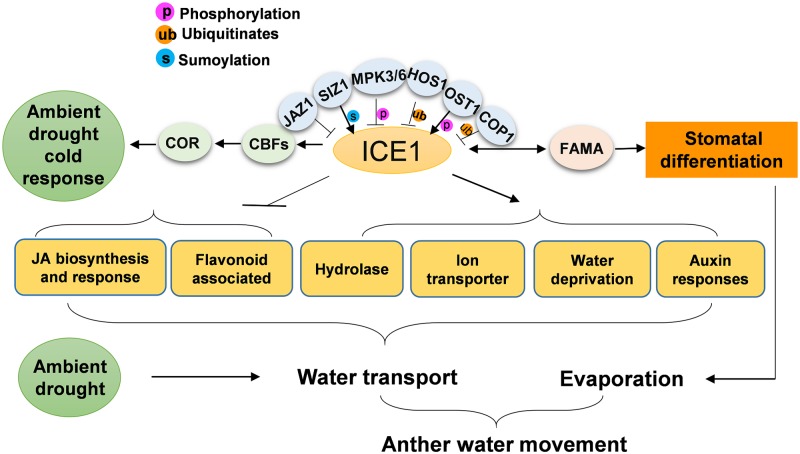
ICE1 modulates water movement in the anther.Hypothetical signal pathways deduced from GO enrichment analysis are highlighted in the yellow boxes. ICE1 modulates water transport and stomatal differentiation to control water transport in the stamen and evaporation through stomata in the anther, which can also be affected by ambient drought. On the other hand, ICE1 activates CBF signaling to protect floral tissues from drought and cold stresses.